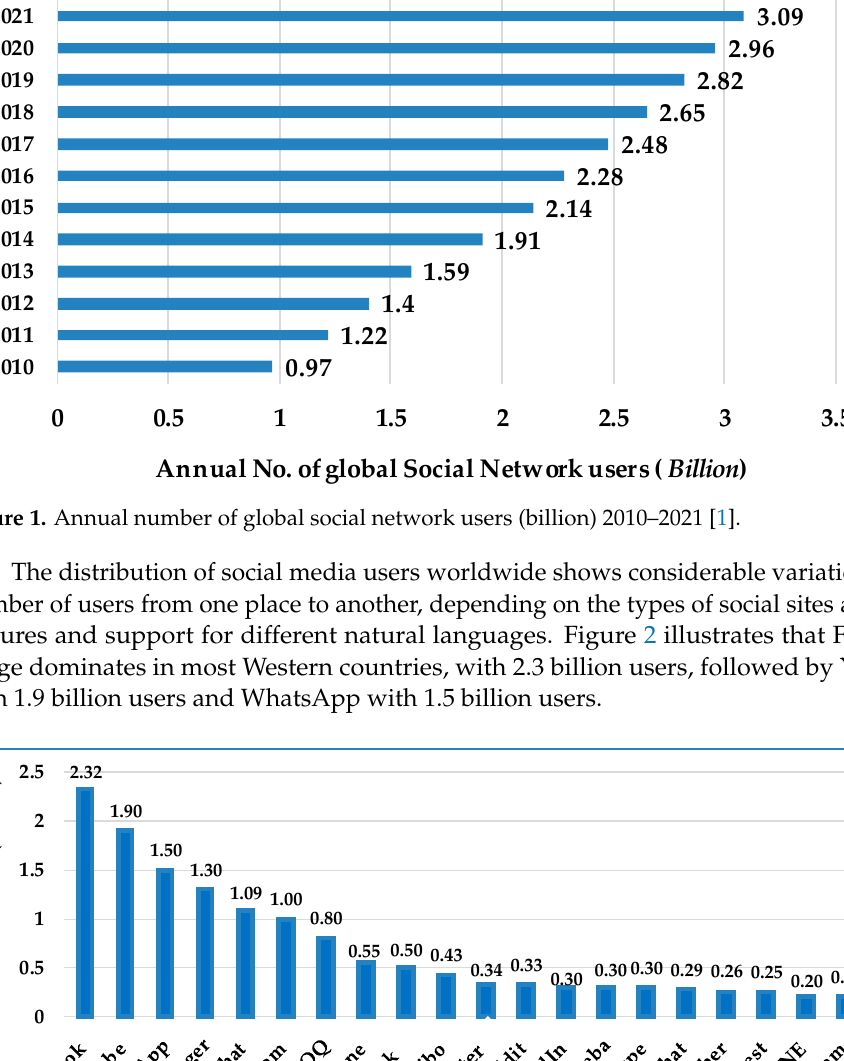
Figure 2. Globally distributed number of users using social media networks [4].